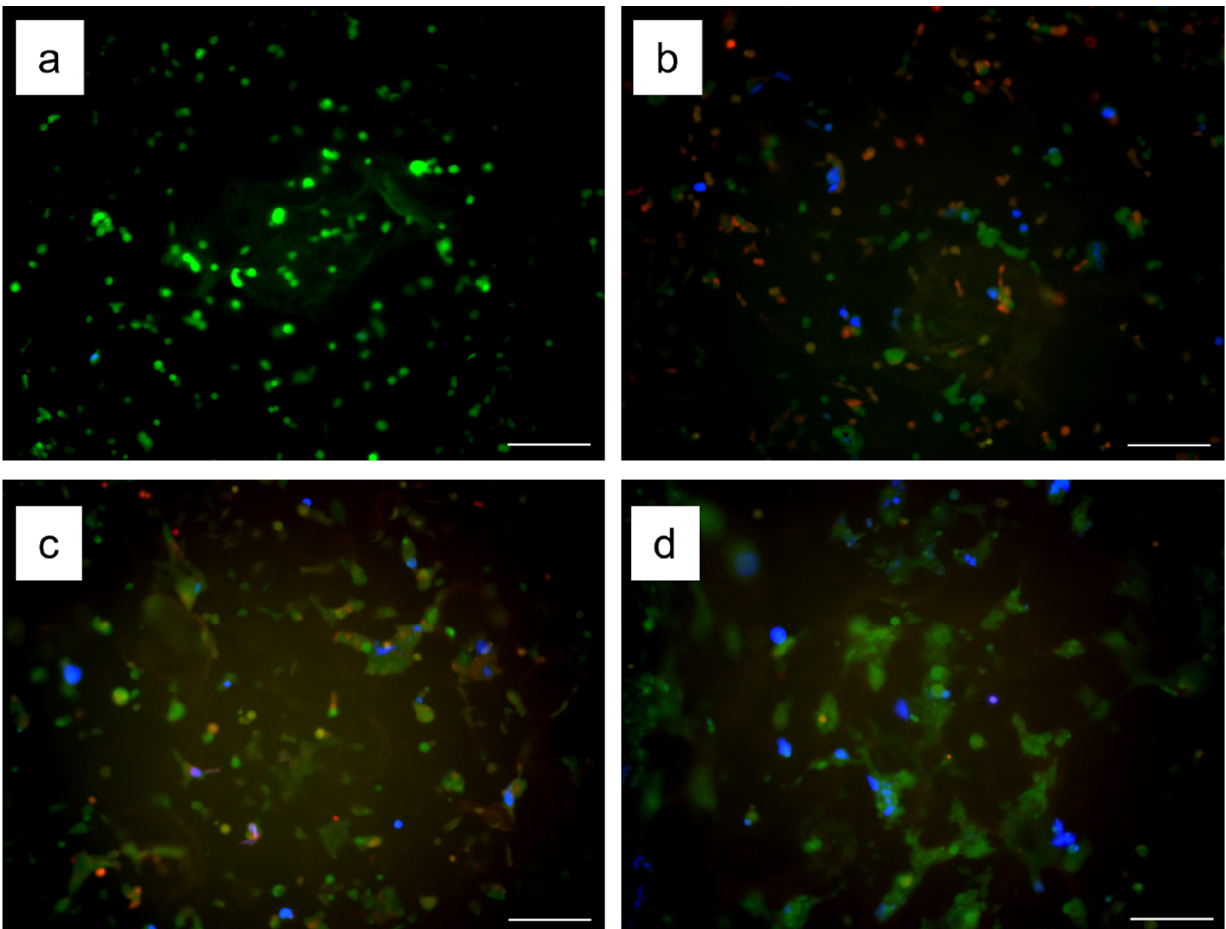
Figure 4. Time course of transfection by Gelatin-Ph nanofibers with Lipofectamine/pDNA complexes. The fluorescent images of cells (green), cells seeded later (red), and transfected cells (blue) on days ( a ) 1, ( b ) 2, ( c ) 3, and ( d ) 4 after initial cell seeding. Bars are 200 μ m.